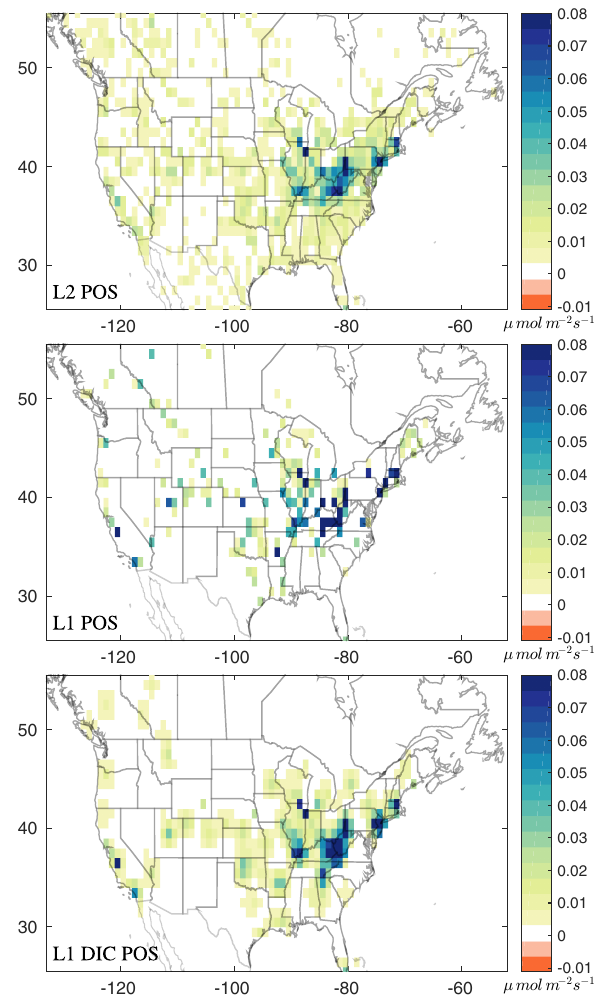
Figure 7. Emission estimates from the methods L2 POS, L1 POS, and L1 DIC POS inverted from noisy simulated methane measure- ments. The true flux field is shown in Fig.